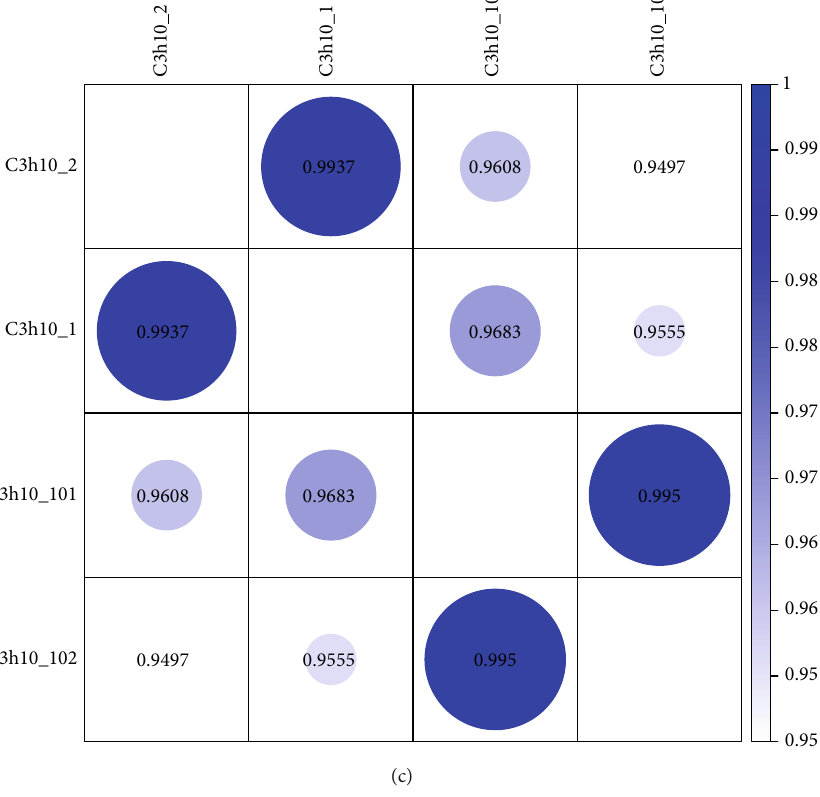
Figure 4: An overview of the genome-wide analysis of mRNA-lncRNA-circRNA study design and correlation coe ffi cient analysis of two biological repeats for 5-AZA-treated and untreated cells. (a and b) An overview of the genome-wide analysis of mRNA-lncRNA-circRNA study design. (c) Correction between the two biological repeats for each sample (C3h10_1 VS C3h10_2: correlationindex = 1 ; C3h10_101 VS C3h10_102: correlationindex = 0 : 995